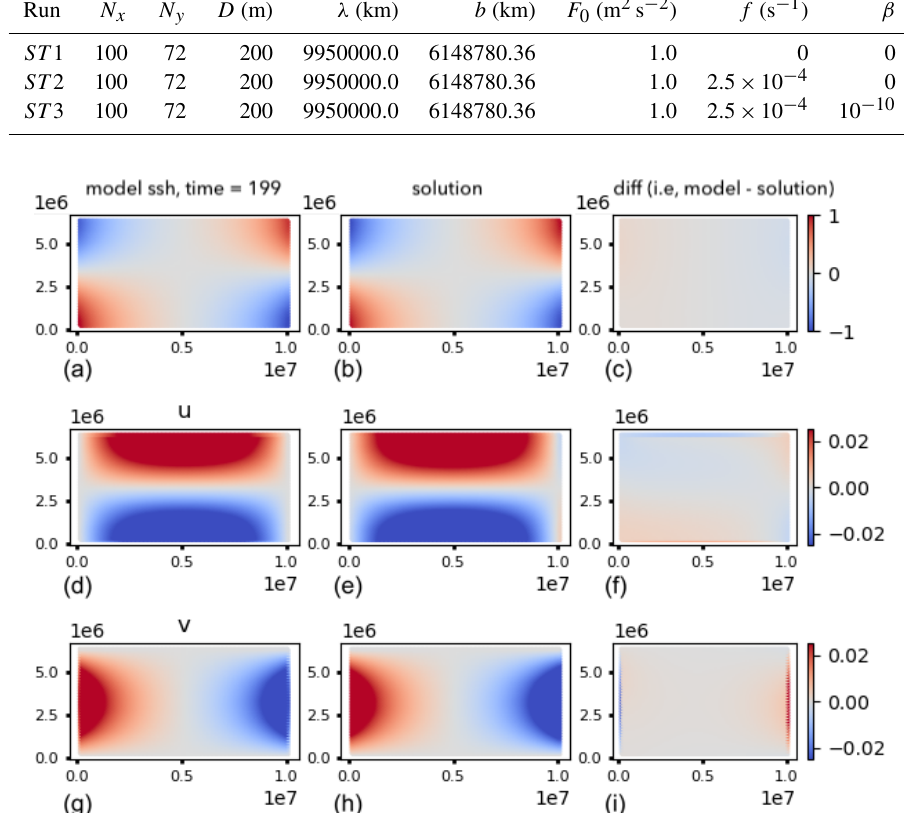
Figure B2. Comparison of MPAS-Ocean results against theoretical predictions by Stommel (1948) for the non-rotating case ( f = 0): sim- ulation (a, d, g) ; analytical solutions (b, e, h) and their difference (c, f, i) for the sea surface height (m), zonal velocity u and meridional velocity v (ms − 1 ). Horizontal axes are x and y (m). Comparisons were made after the model reached an equilibrium solution.